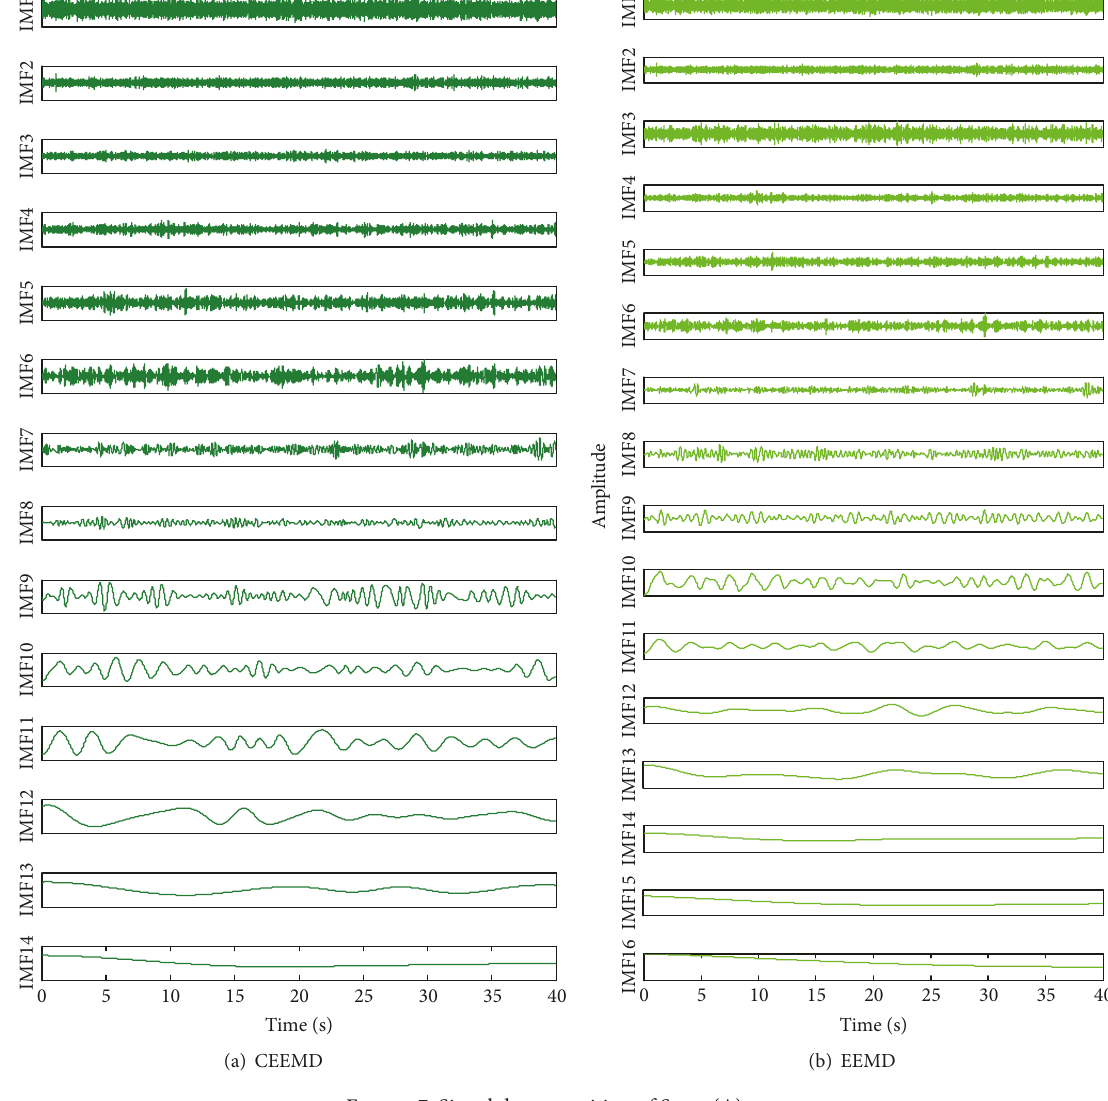
Figure 7: Signal decomposition of Stage